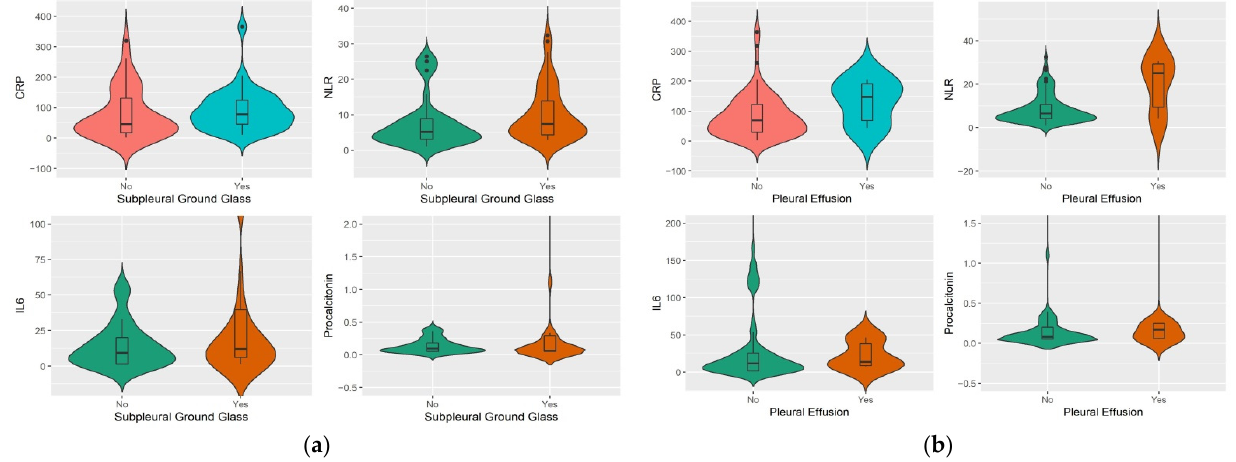
Figure 7. Difference in medians of inflammatory markers by presence on CT: ( a ) subpleural ground glass; ( b ) pleural effusion.